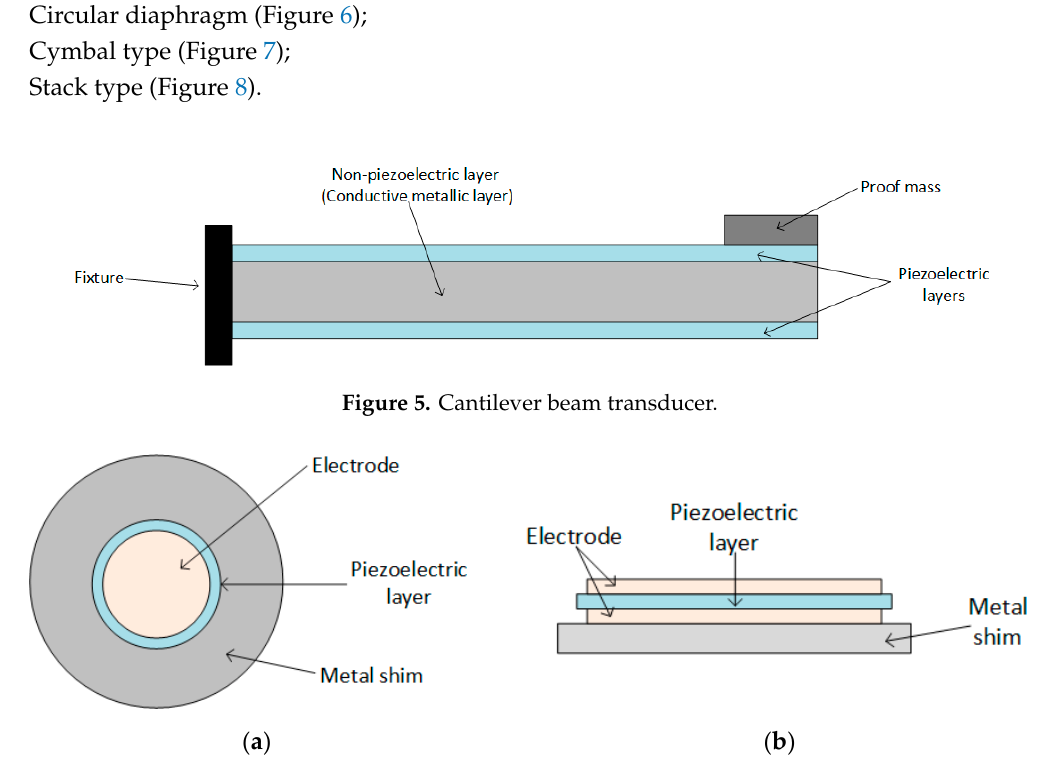
Figure 6. Circular diaphragm transducer: ( a ) Front view; ( b ) Side view.